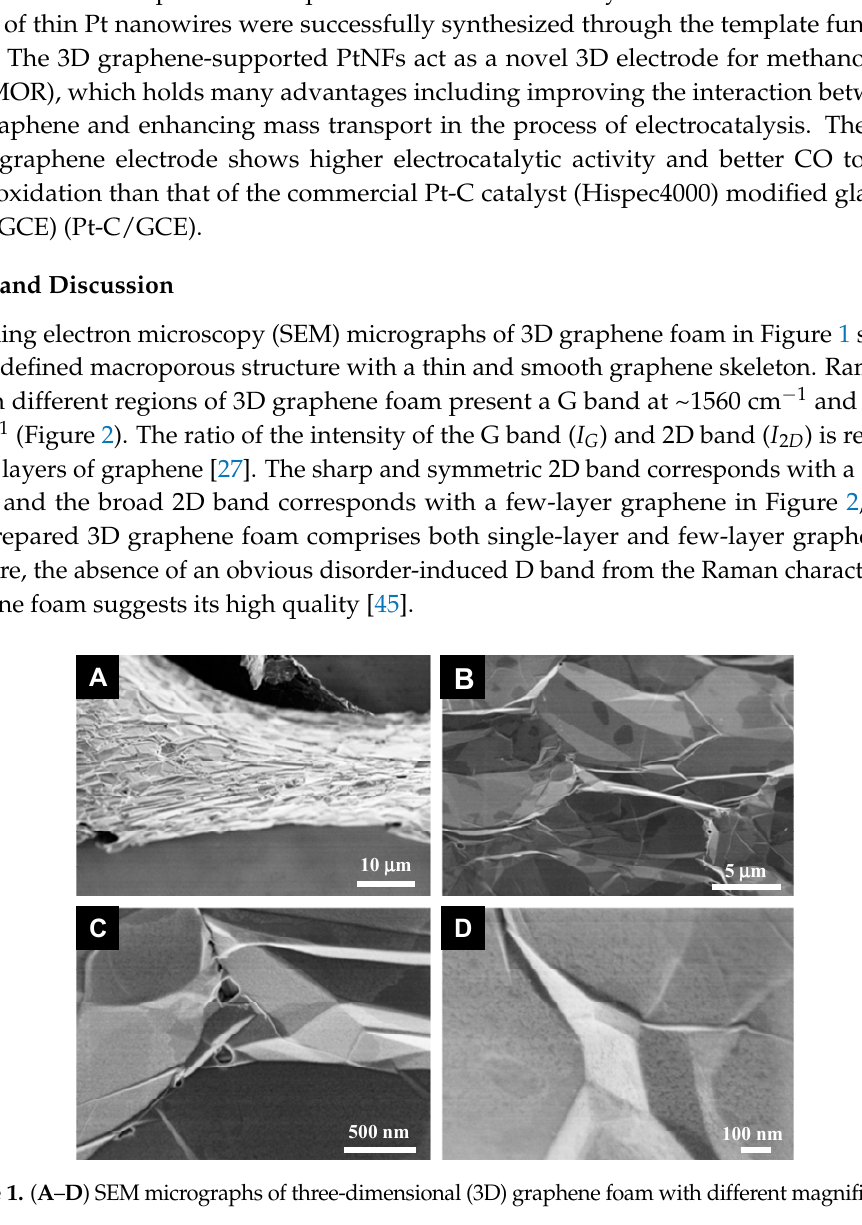
Figure 1. ( A – D ) SEM micrographs of three-dimensional (3D) graphene foam with different magnifications.